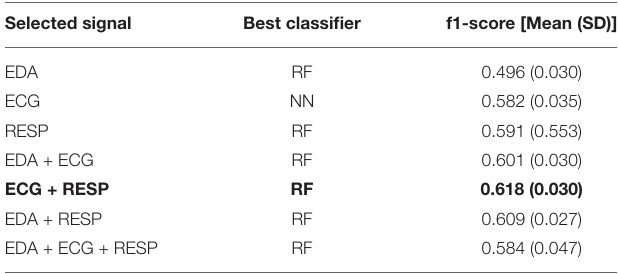
TABLE 10 | Best score achieved by the model to predict task modality for each combination of physiological signals. Selected